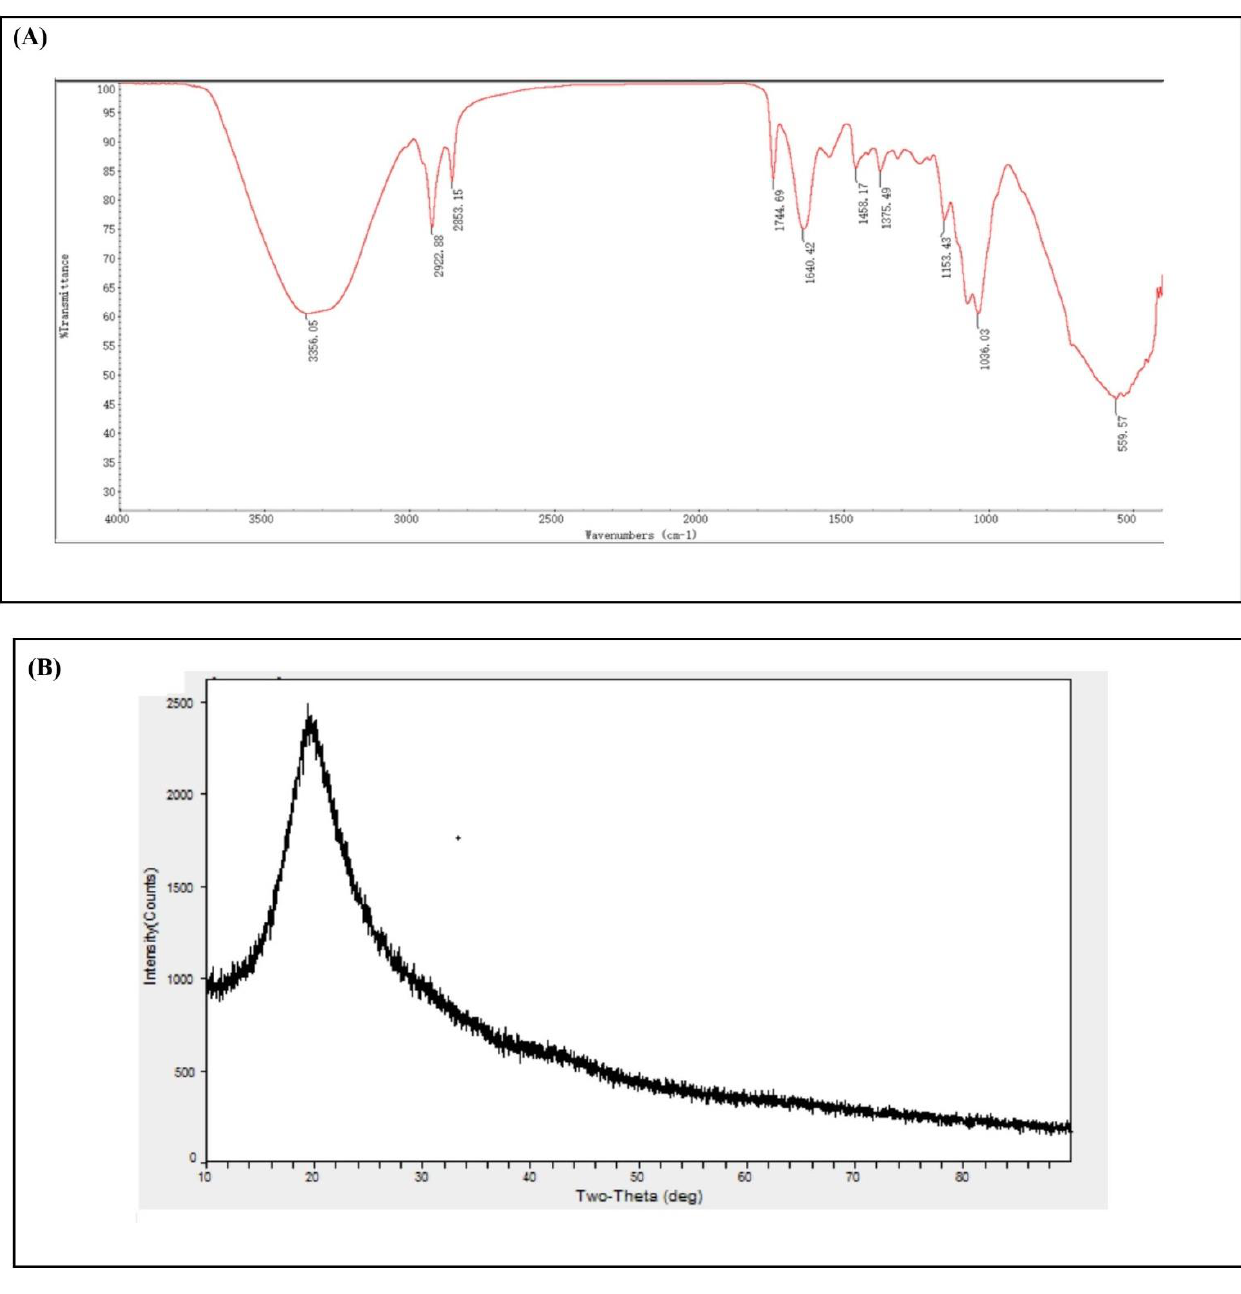
Figure 5. Fourier transform infrared spectroscopy ( A ) and X-ray diffraction crystallography ( B ) of Metarhizium anisopliae –chitosan nanoparticles.